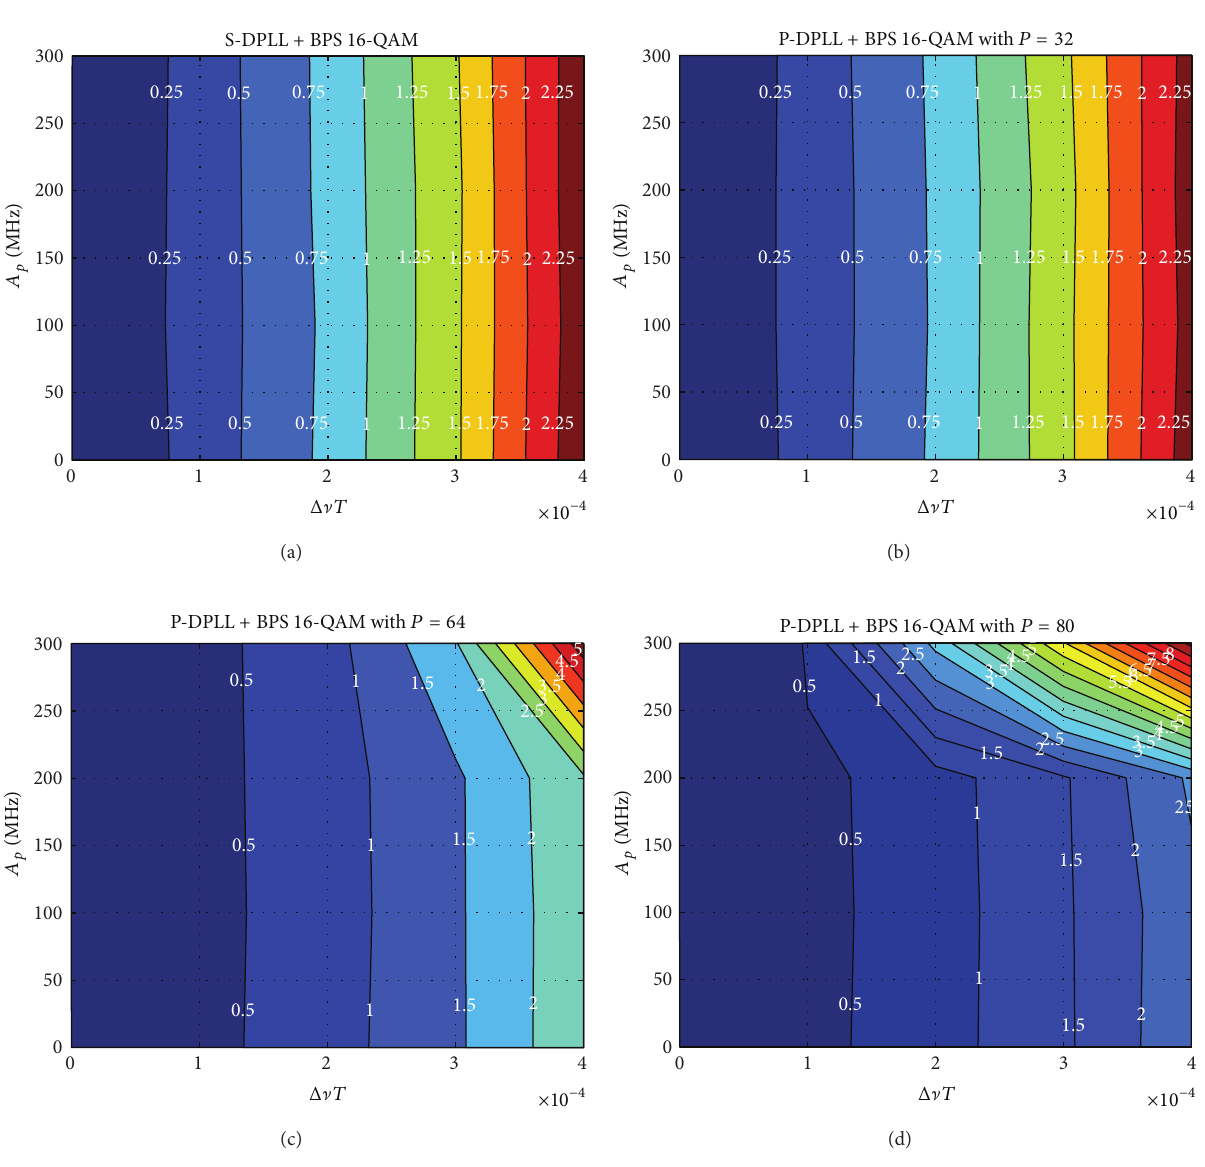
Figure 19: Surface of performance of the P-DPLL + BPS architecture under the joint effect of laser phase noise and frequency fluctuation for several parallelization factors with Δ𝑓 𝑐 = 35 kHz, 1/𝑇 = 32 Gs/s, 𝑁 = 21 , and 𝐵 = 32